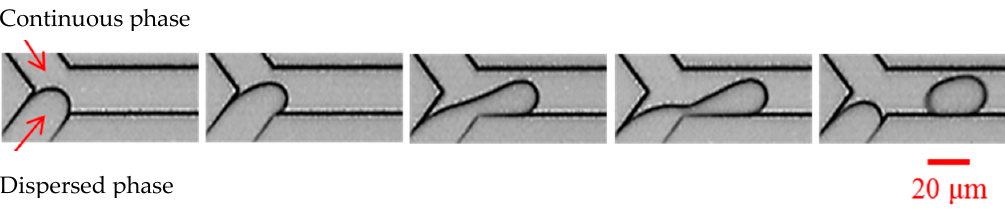
Figure 8. Oil droplet formation in a Y-junction microfluidic device (reprinted with permission from Elsevier [73]).